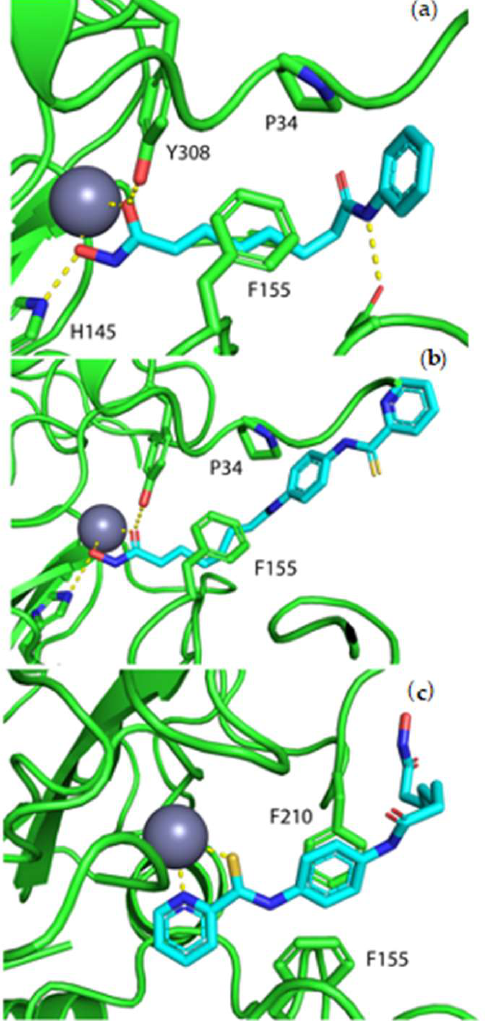
Figure 3. SAHA and Jazz90 binding to HDAC2. Jazz90 was docked into HDAC2 (PDB ID: 4LXZ). ( a ) Crystal structure of SAHA (cyan) complexed with HDAC2, ( b ) Jazz90 docked into HDAC2 with hydroxamate coordination to zinc, and ( c ) Jazz90 docked into HDAC2 with pyridinecarbothioamide coordination. Green ribbons and sticks represent the active site of HDAC2. (Blue atoms = nitrogen, yellow = sulfur, and red =